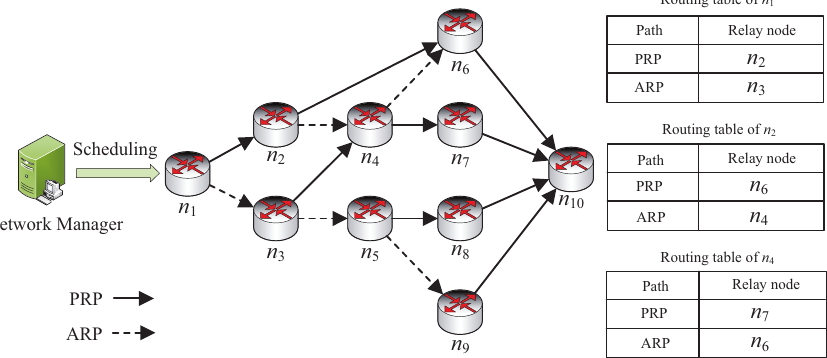
Figure 2. An example of the graph routing retransmission